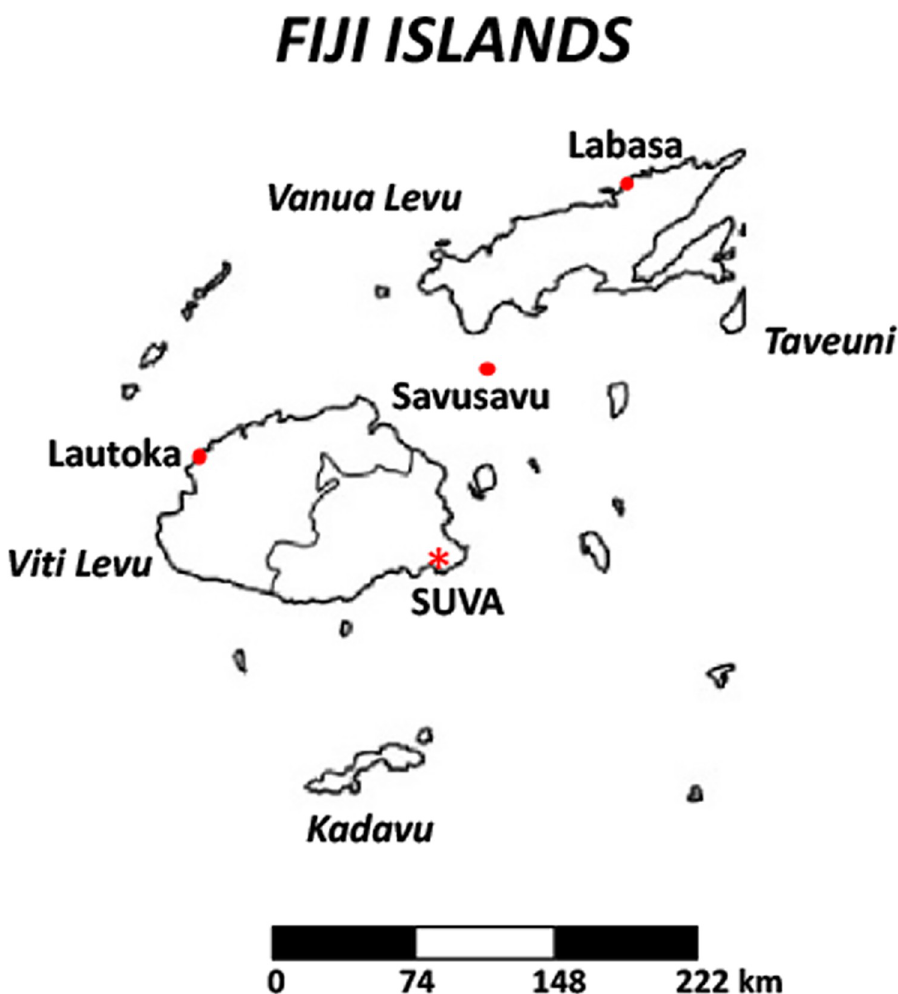
Fig 1. Map of the archipelago of Fiji showing the main island of Viti Levu, including the capital city of Suva. The Eastern half of Viti Levu comprises what is known as the Central Division.